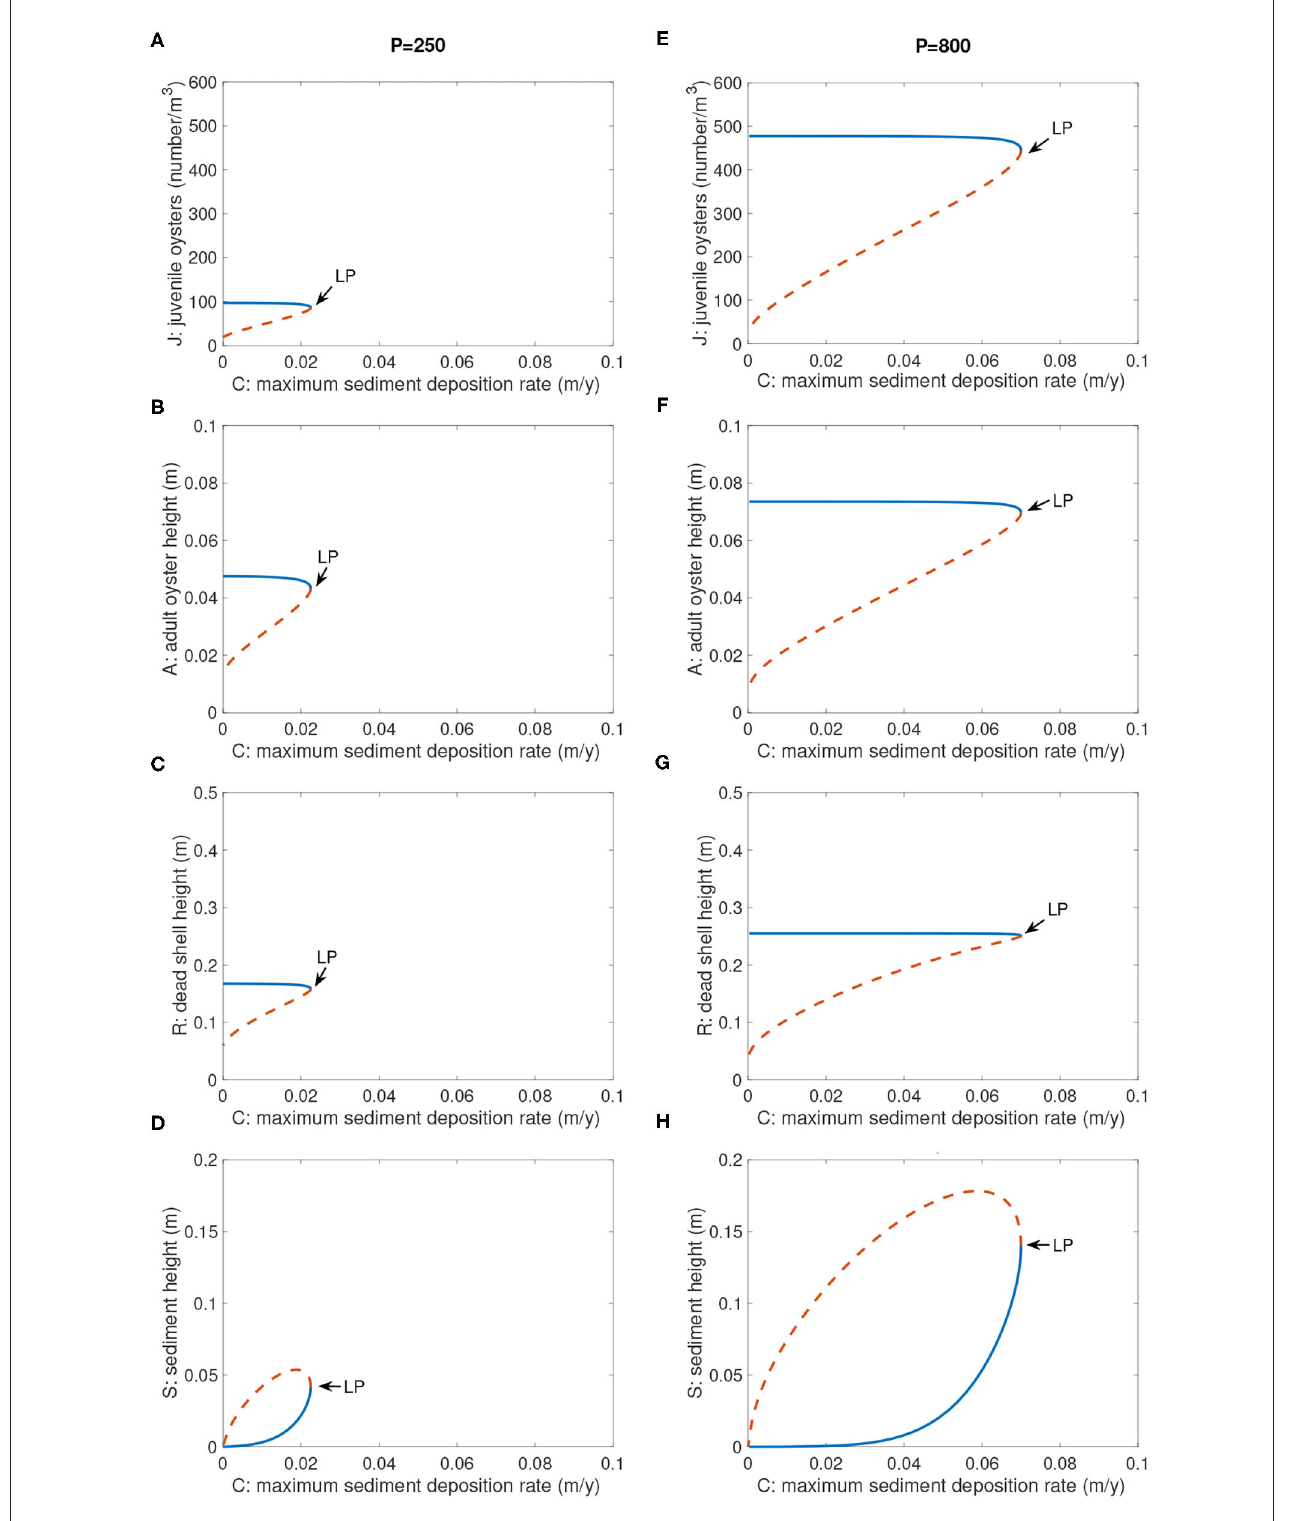
FIGURE 7 | Bifurcation diagrams of positive equilibria for parameter C . (A–D) P = 250, (E–H) P = 800. Not shown is the extinction equilibrium line for J , A , and R , which is at the abscissa for all values of C and P . Other parameters are as in Table 2 . Blue solid branch: stable; orange dashed branch: unstable.